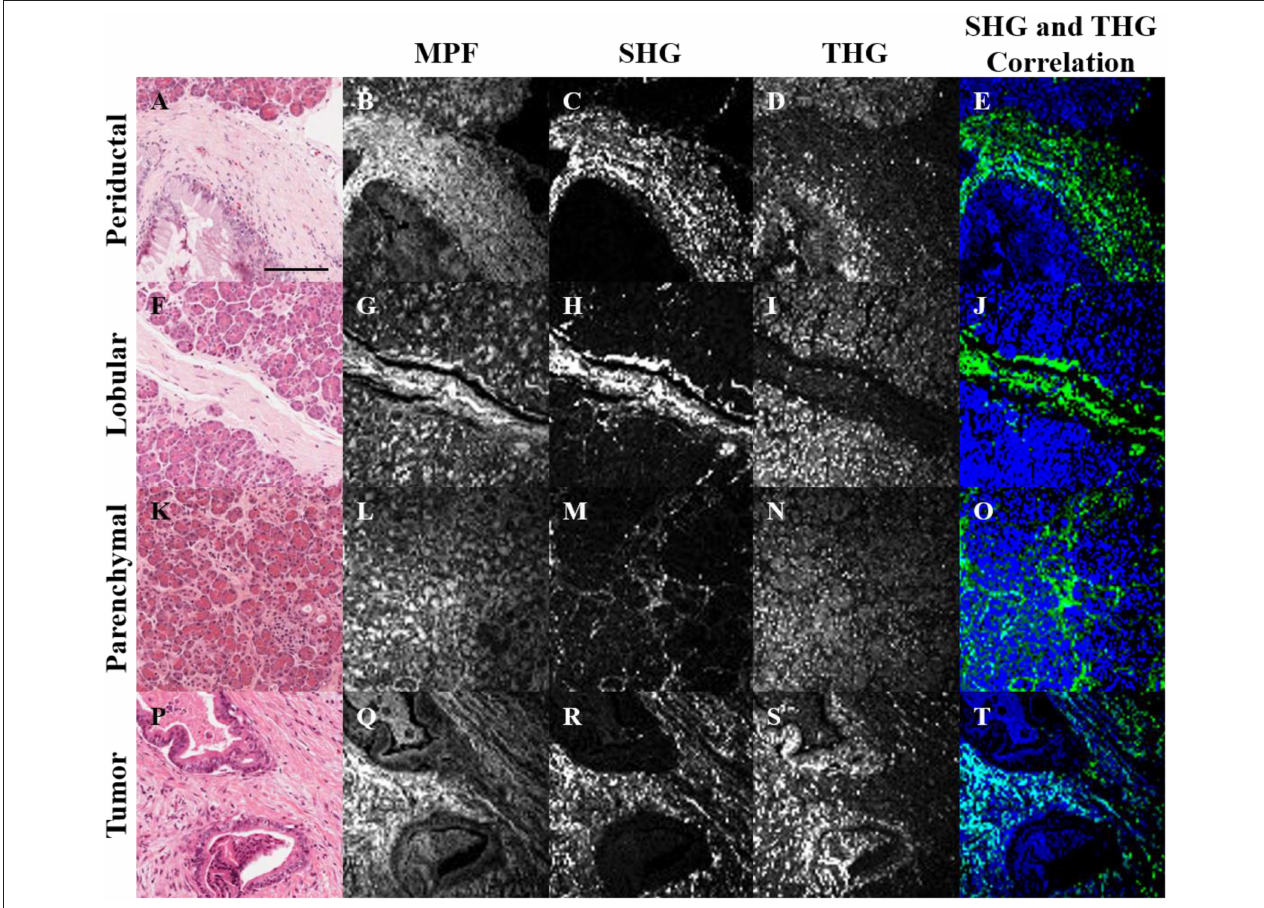
FIGURE 1 | Bright-field (A,F,K,P) , MPF (B,G,L,Q) , SHG (C,H,M,R) , and THG (D,I,N,S) images of periductal (A–E) , lobular (F–J) and parenchymal (K–O) regions of normal pancreas, as well as tumor tissue (P–T) . SHG and THG images were correlated (E,J,O,T) , where regions with correlation between SHG and THG are visualized in cyan, while uncorrelated SHG and THG are visualized in green and blue, respectively. The scale bar (in A ) represents 125 µ m.